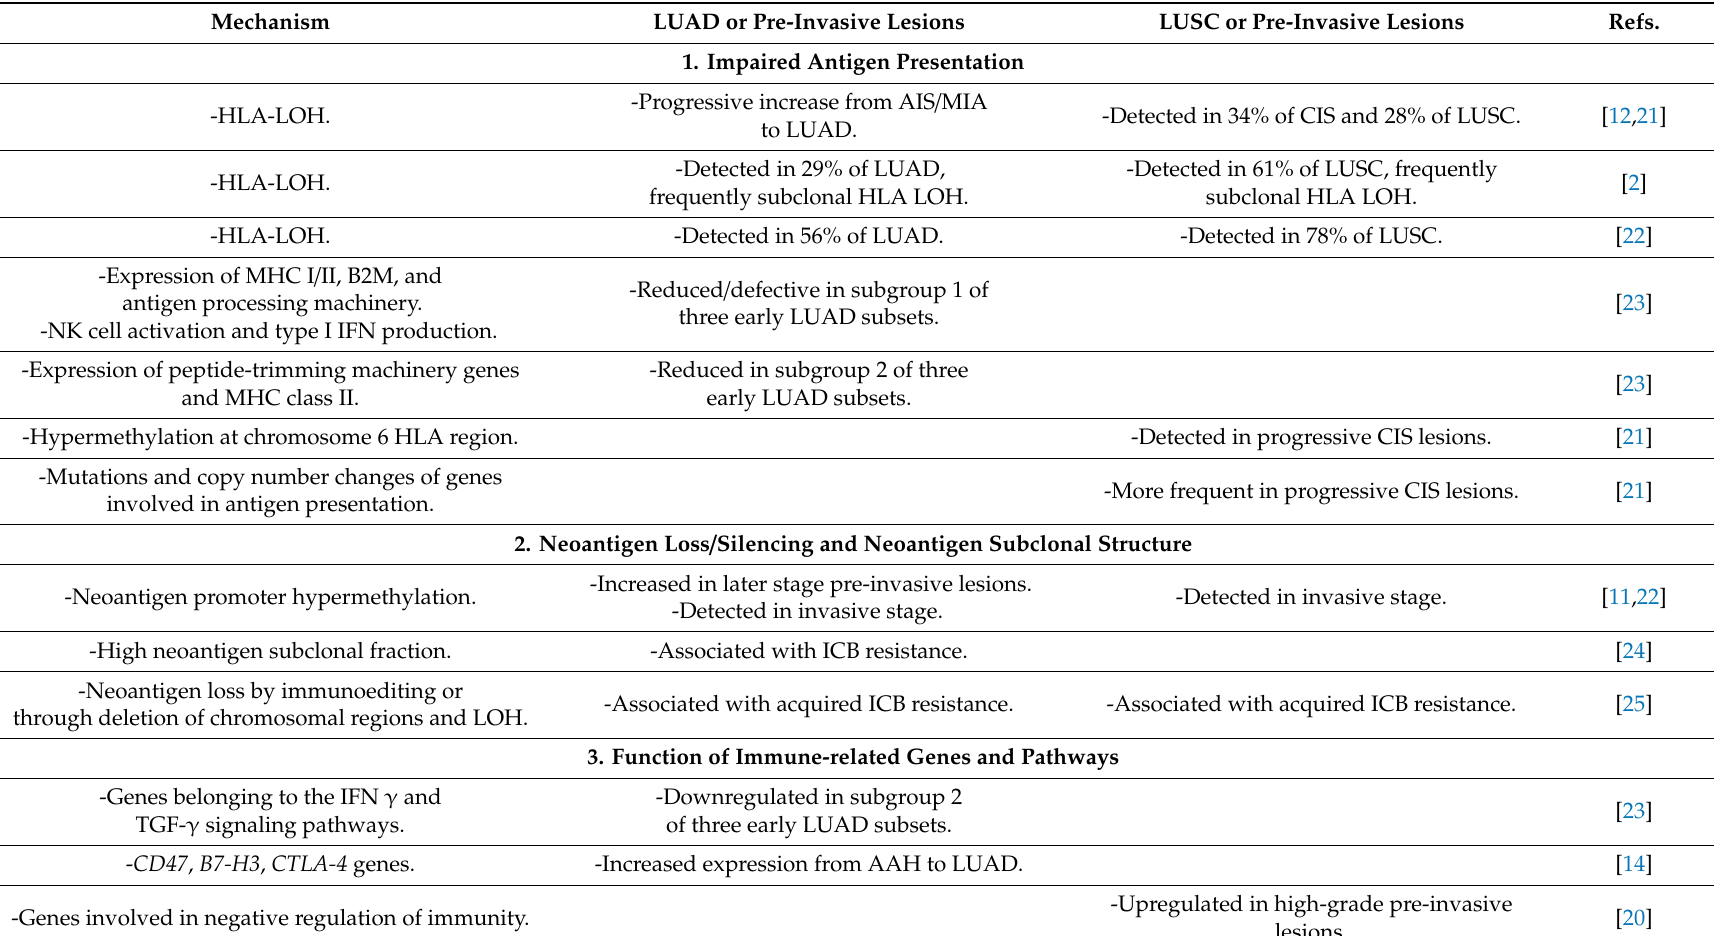
Table 1. Immune escape and immunosuppressive mechanisms in pre-invasive lesions, in invasive LUAD and LUSC, and in immunotherapy